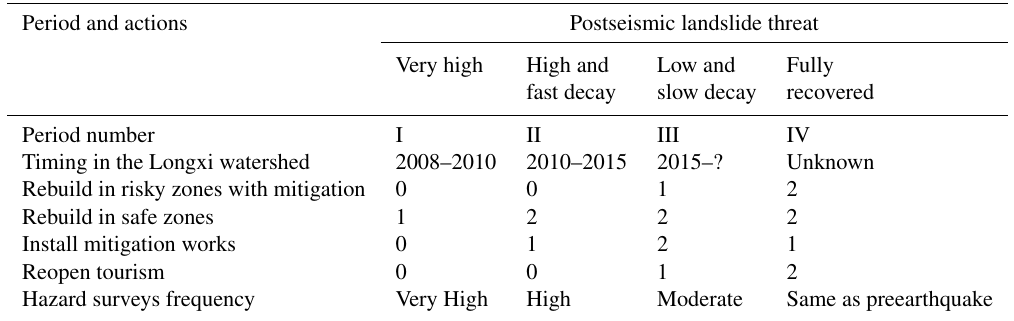
Figure 11. (a) The total values of the built-up features, investments and direct economic losses over the period between 2007 and 2018 in the Longxi area. (b) The total value of elements at risk exposed to debris flows and floods. The blue line indicates the amount of investment in mitigation measures. The values were adjusted with the inflation rate. (c) The total number of buildings that are exposed to debris flows and floods. Table 6. Suitability of actions after earthquakes, using the Longxi watershed as an example. The numbers denote the following: 0 = not suitable; 1 = somewhat suitable; 2 =